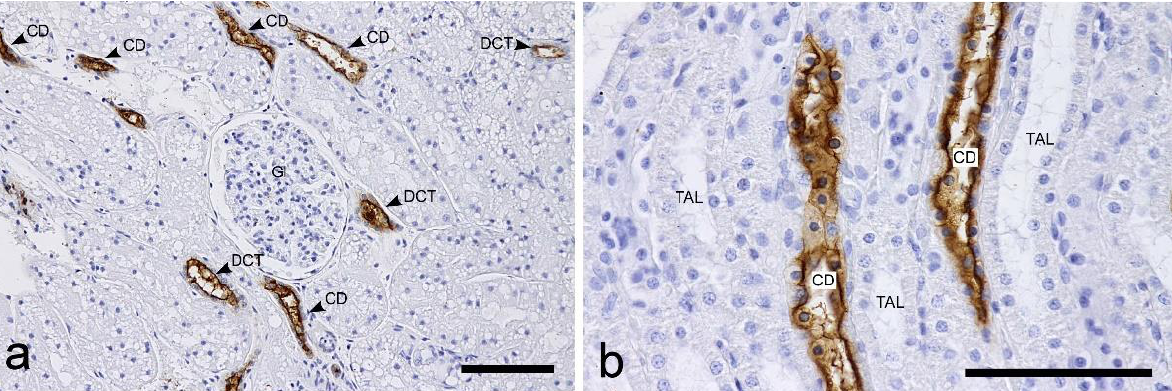
Figure 5. Histochemical staining for concanavalin A (ConA) in the feline kidney. ( a ) Low magnifi-